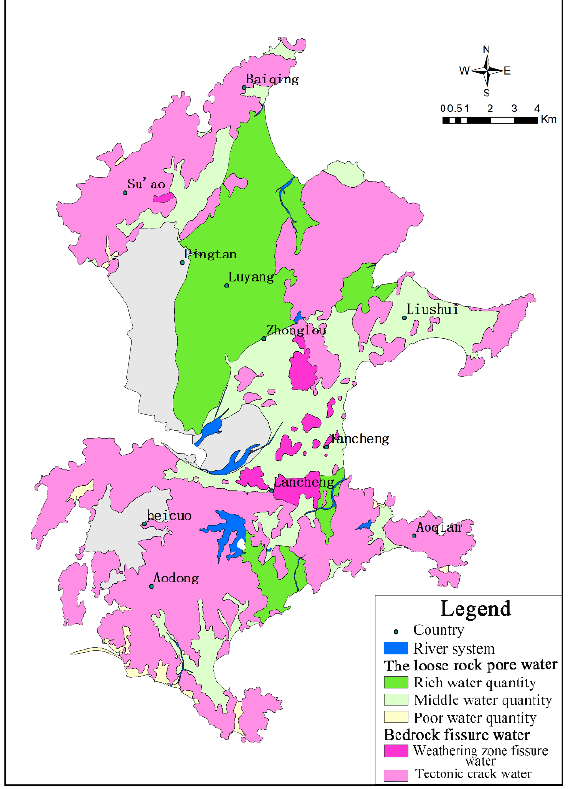
Figure 10. Distribution of shallow underground water yield property in Pingtan Island.